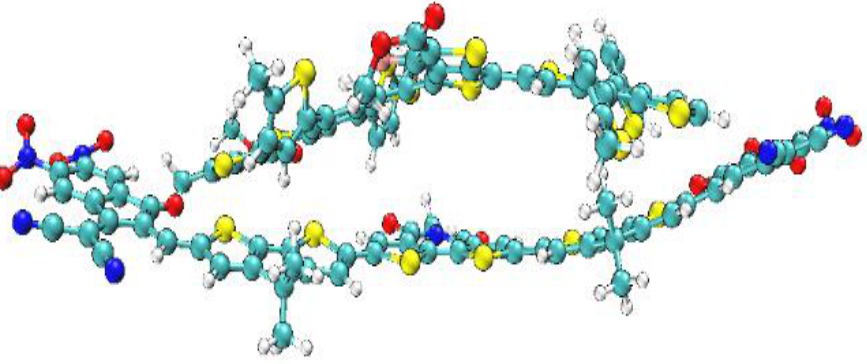
Figure 13. Optimized structure of PTb7-Th with BTIC-U1. Significant dipole moment, subtle reorganization energy, low excitation energy, and sizeable bathochromic shift led us to choose BTIC-U1 over all other fabricated molecules. As a result, the BTIC-U1 molecule is selected as the best acceptor molecule. PTB7-Th, on the other hand, is a commonly used donor polymer in CT analysis. At the MPW1PW91/6- 31G* functional, the composite made up of PTB7-Th and BTIC-U1 is optimized. Figure 14 depicts the BTIC-U1: PTB7-Th complex HOMO and LUMO pictorially. The figure clearly demonstrates that the donor polymer is aligned in a precisely parallel direction to the acceptor BTIC-U1. When undergoing CT or excitation, this orientation is optimal. The findings suggest that the density of charge in the HOMO state is located on the electron-rich donor